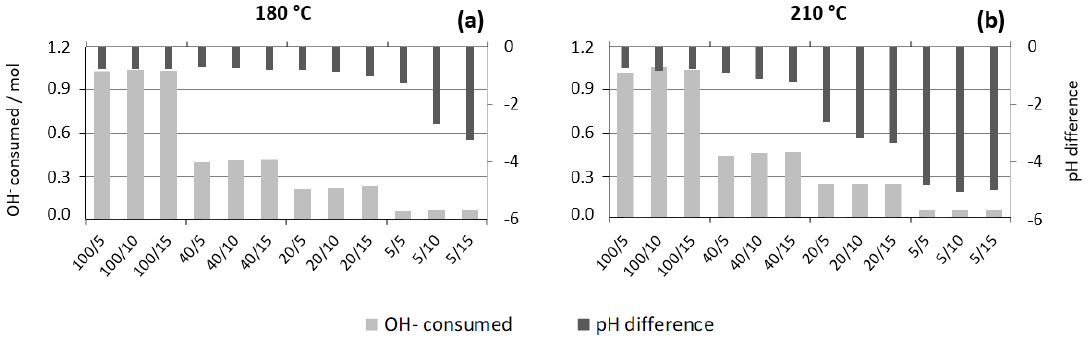
Figure 8. The difference in the pH and calculated consumption of OH − at 180 °C/series A2 ( a ) and 210 °C/series A1 ( b ); constants: 1 h, 800 rpm, S/L: 0.1; caption horizontal axis: NaOH conc./oxygen pressure.